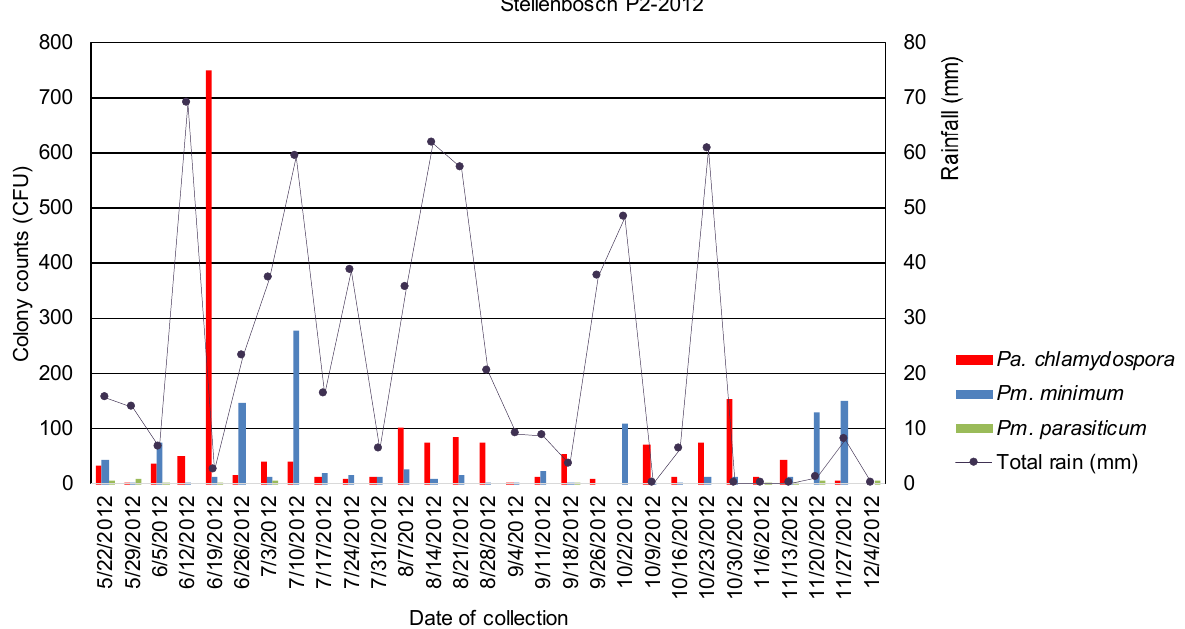
Figure 7. Phaeomoniella and Phaeoacremonium spp. cfu cultured from five vaseline coated microscope slides affixed to the cordons on each of five vines in vineyard Stellenbosch P2, Western Cape province in 2012. The slides were replaced weekly. Each bar represents the total number of cfu cultured on three Petri